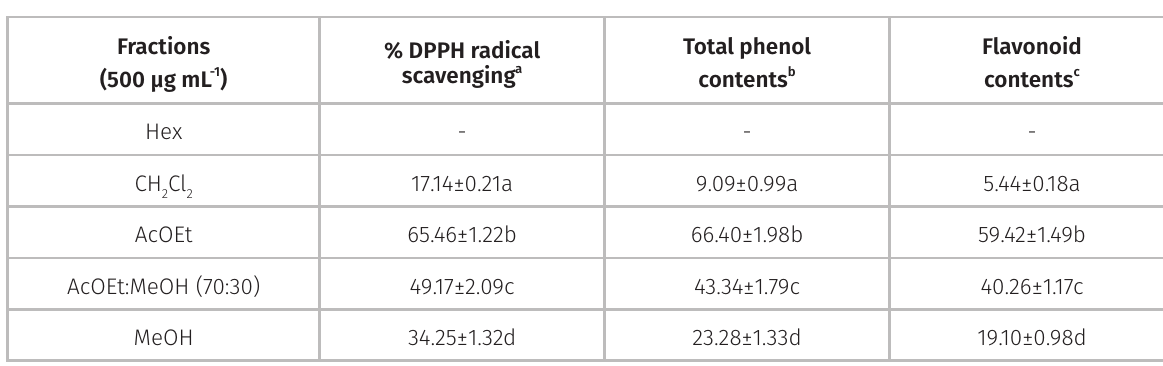
Cl , Ethyl Acetate = AcOEt, Methanol = MeOH) of 2 2